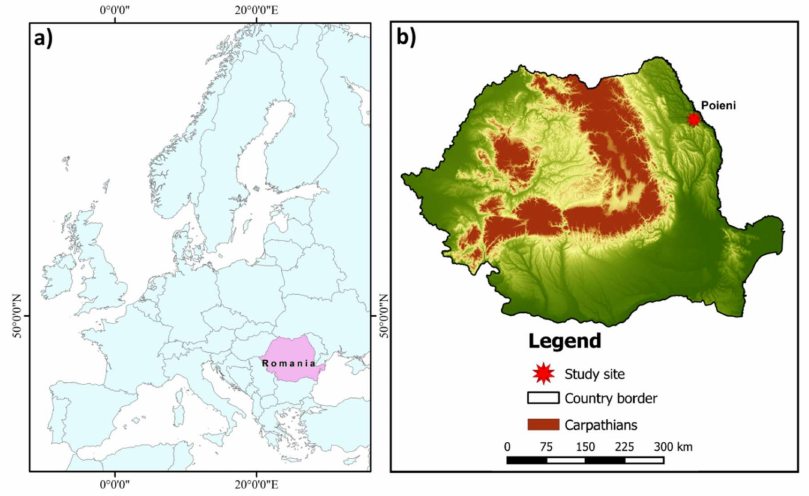
Figure 1. Geographic location of the study area ( a ) and position of the study site within Romania ( b